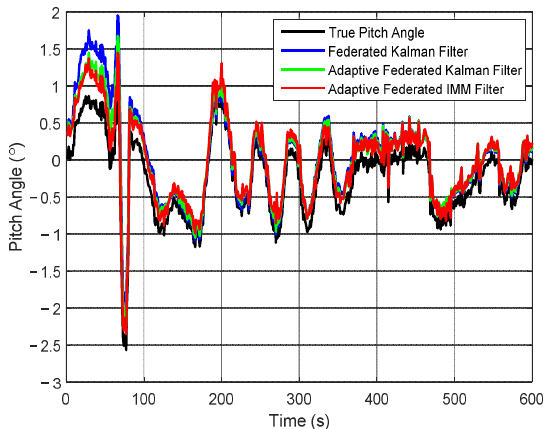
Figure 8. The estimation curves of heading angle error.